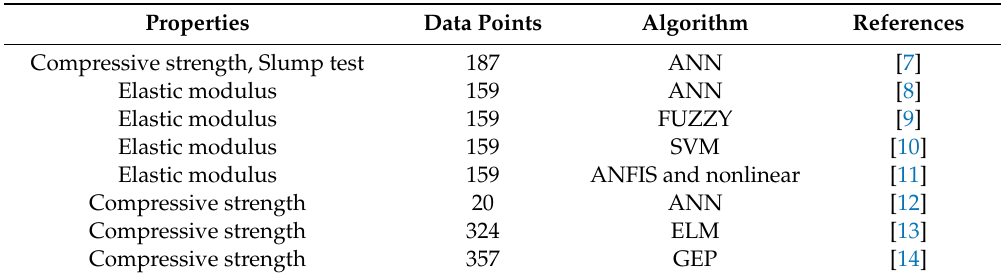
Table 1. Algorithm used in prediction properties of high strength